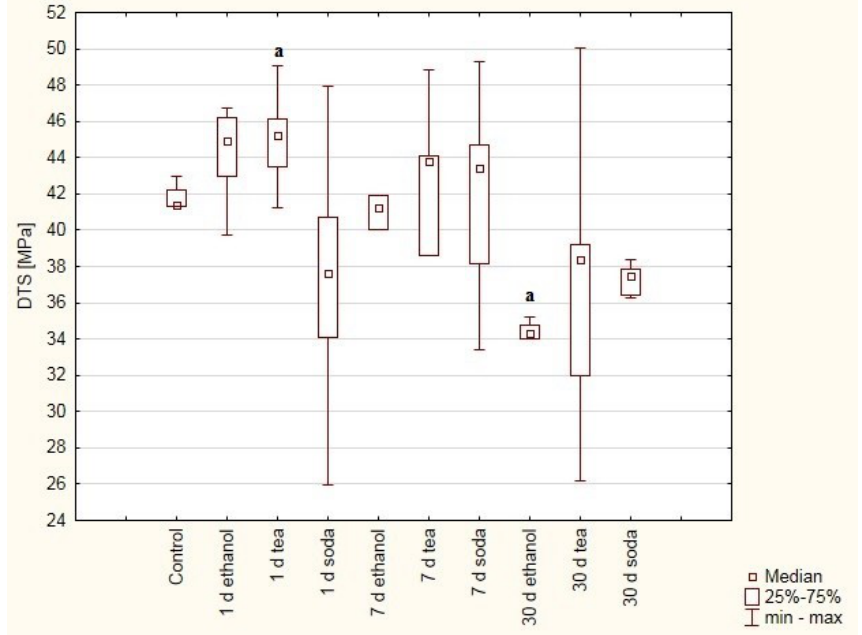
Figure 3. Box and whiskers plot of diametral tensile strength (DTS). Values were obtained for samples made of Breeze cement treated with ethanol (75%), green tea and baking soda (2.5%) solutions after one, seven or 30 days and samples immersed for seven days in distilled water as control. Statistically significant differences were detected between: (a) 1 day in tea solution vs. 30 days in ethanol solution.